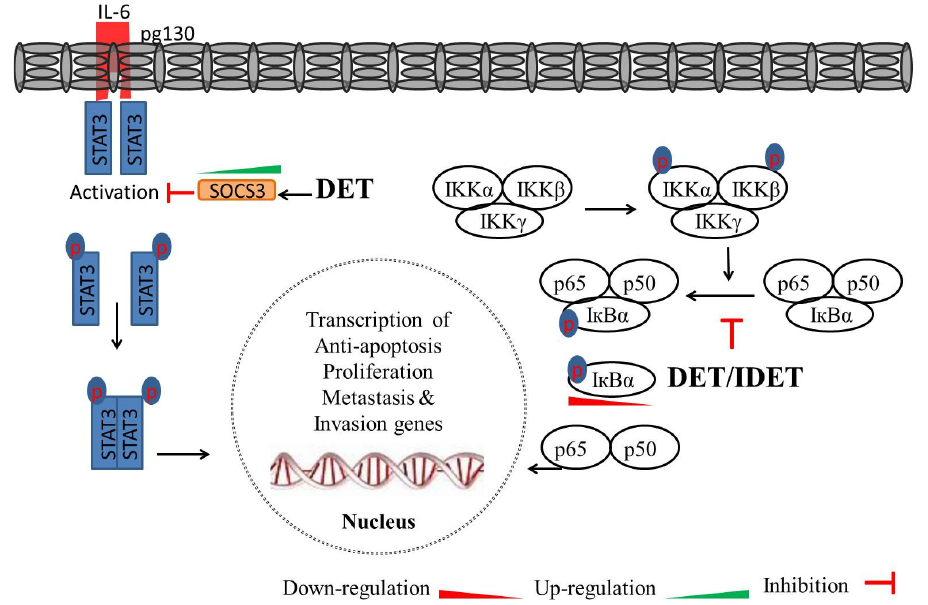
Figure 5. A schematic model of DET/IDET-induced STAT3 and NF- к B inhibition. DET upregulates the expression of suppressor of cytokine signaling 3 (SOCS3), which is a major component for the negative regulation of IL-6 signaling cascade, and inhibits STAT3 activation by reducing phosphory- lation at tyrosine 705. DET/IDET inhibits NF- κ B activation induced by various inflammatory stimuli (TNF, LPS, and IL-1 β ), which activate NF- к B through different pathways. The inhibition of NF- к B activation was associated with decreased phosphorylation and degradation of I κ B- α , as well as upstream activation of IKK- α /- β and IKK kinase activities. DET/IDET downregulates the expression of NF- к B- and STAT3-regulated gene products involved in anti-apoptosis, cell proliferation, metas- tasis, and invasion.